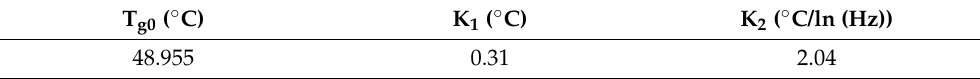
quency. Table 4. Defining parameters of T g evolution ( ◦ C) with the glass fiber volume percentage and frequency.